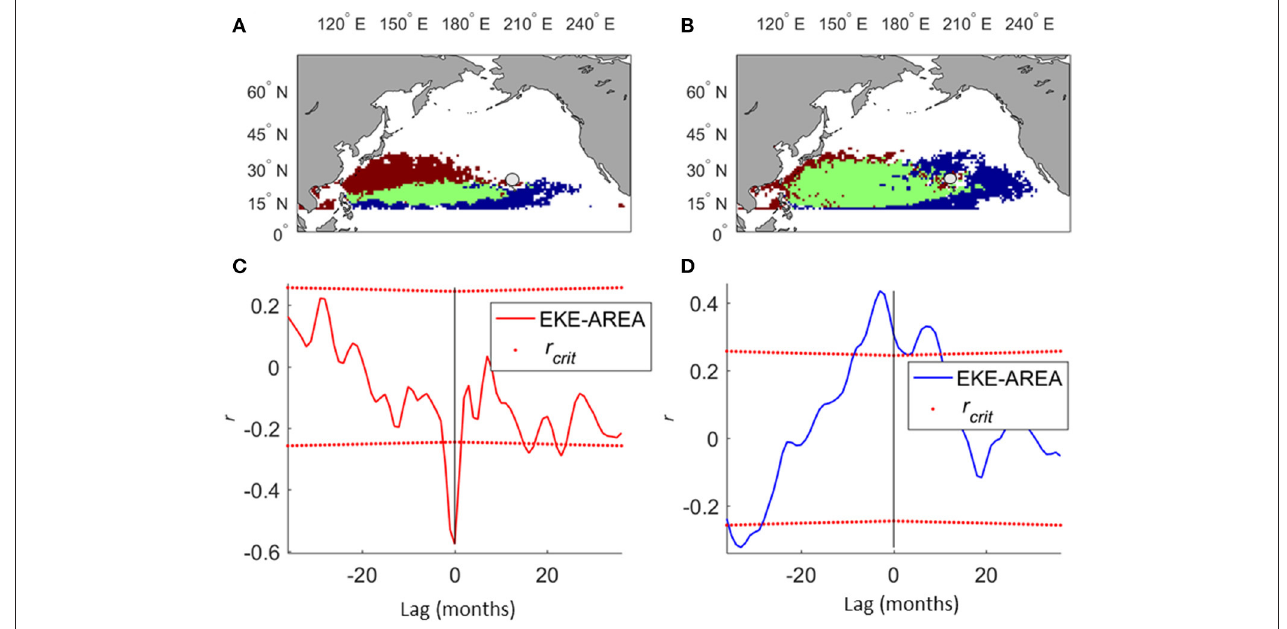
FIGURE 5 | Drivers of spatiotemporal differences in gyre extent based on dynamic height and oligotrophic threshold chl a . (A) Extent of gyre in February 2003 showing topographic (red) and pigment (blue)- based extents and region of overlap (green). (B) Same as (A) , but for September 2003. (C) Cross correlation of mean eddy kinetic energy (EKE) in region represented solely by the physical definition with areal extent of that region. (D) Same as (C) , but in extents solely represented by oligotrophic threshold chl a .